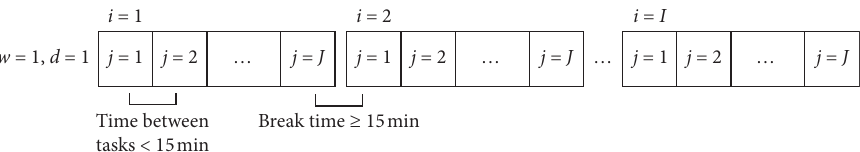
Figure 1: The structure of a feasible duty.